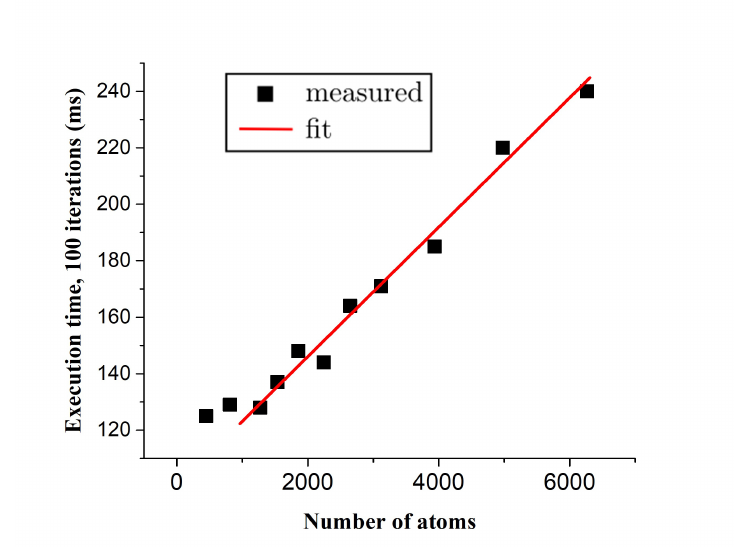
Figure 5. Total execution time, in milliseconds, for 100 iterations of atom relaxation including both gold and molecule computations. A linear relation between the substrate size and the execution time is observed. Again for a smaller number of substrate atoms, the execution time is nearly constant indicating an incomplete utilization of all GPU